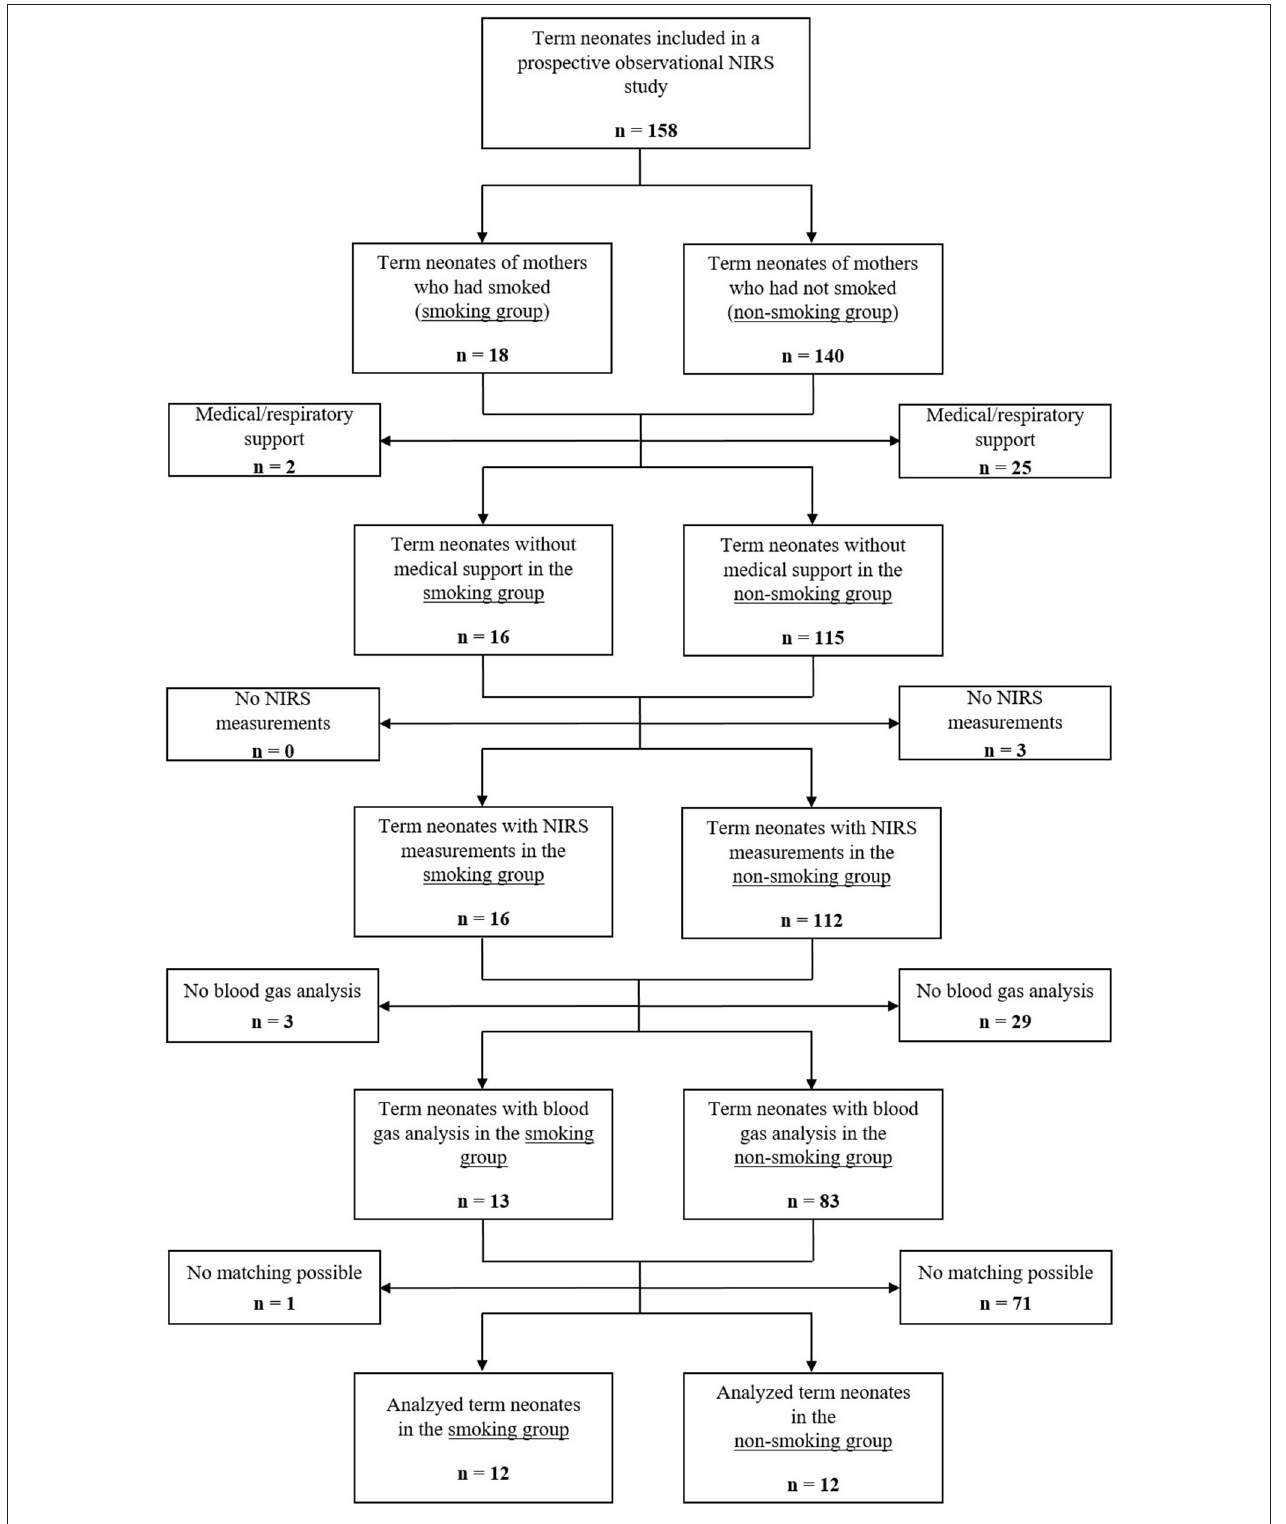
FIGURE 1 | Study flow chart showing the number of included term neonates and rationales for exclusion.